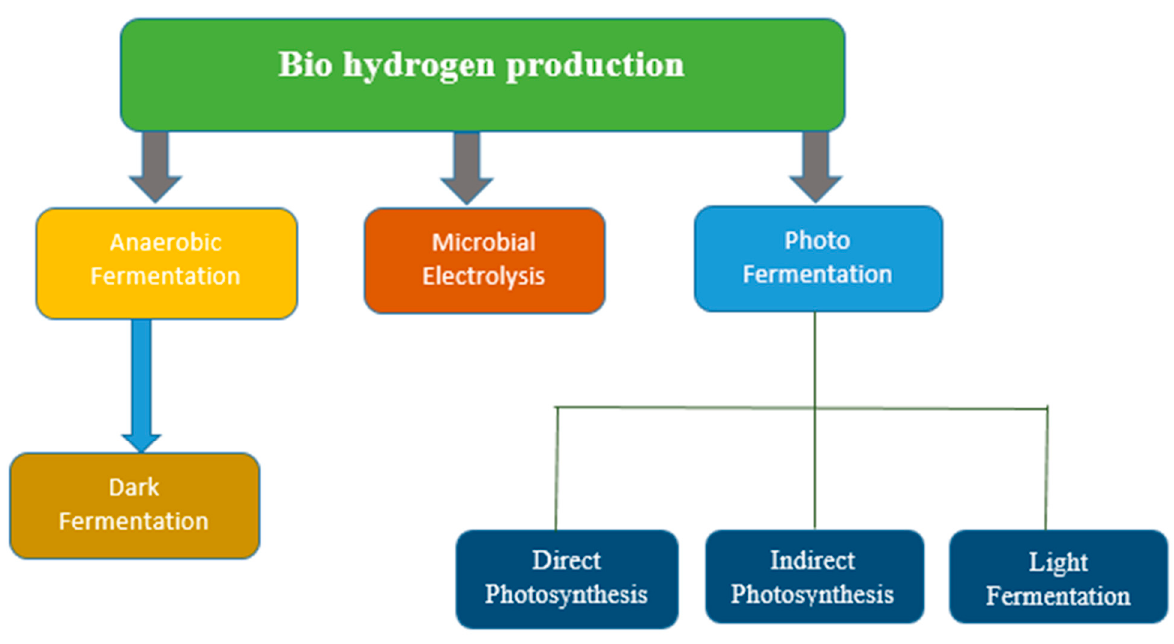
Figure 6. Biohydrogen production process.